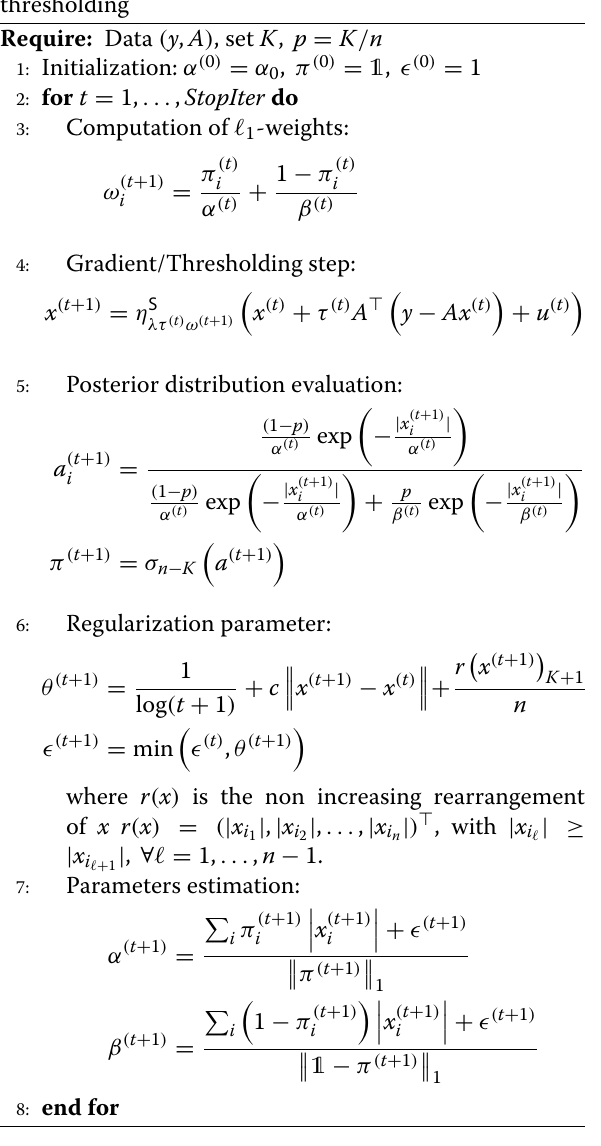
Algorithm 1 2-LMM-tuned iterative shrinkage-